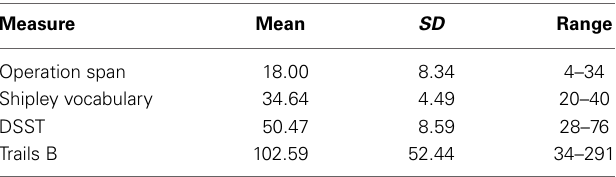
Table 1 | Cognitive battery scores for older adults.